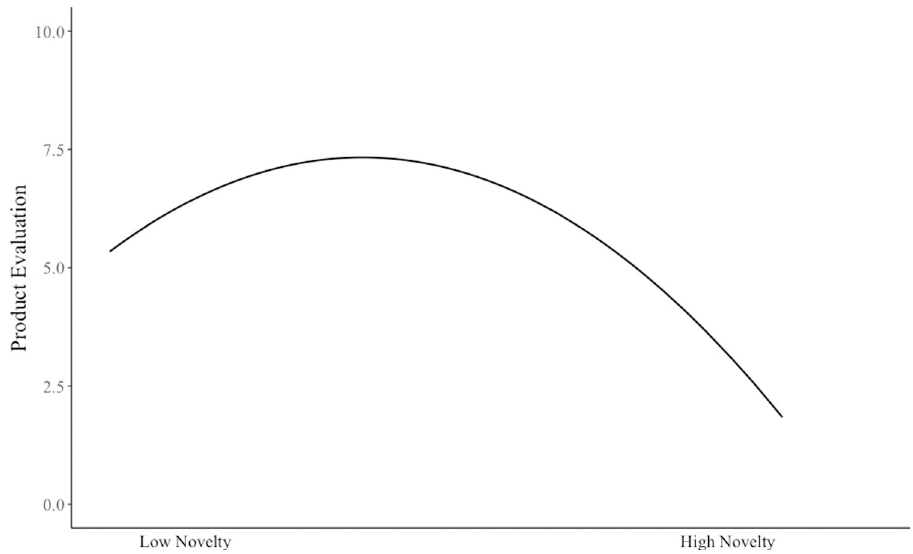
Fig 2. Curvilinear relationship between perceived novelty and product evaluation.